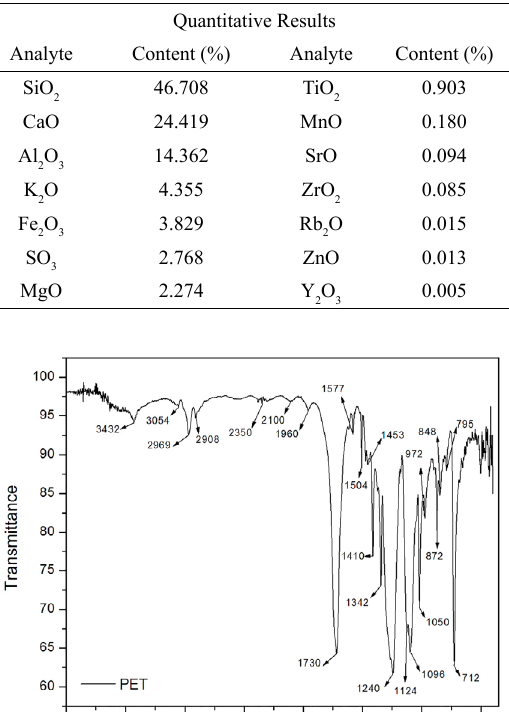
Figure 1. FT-IR spectrum of the PET sample.